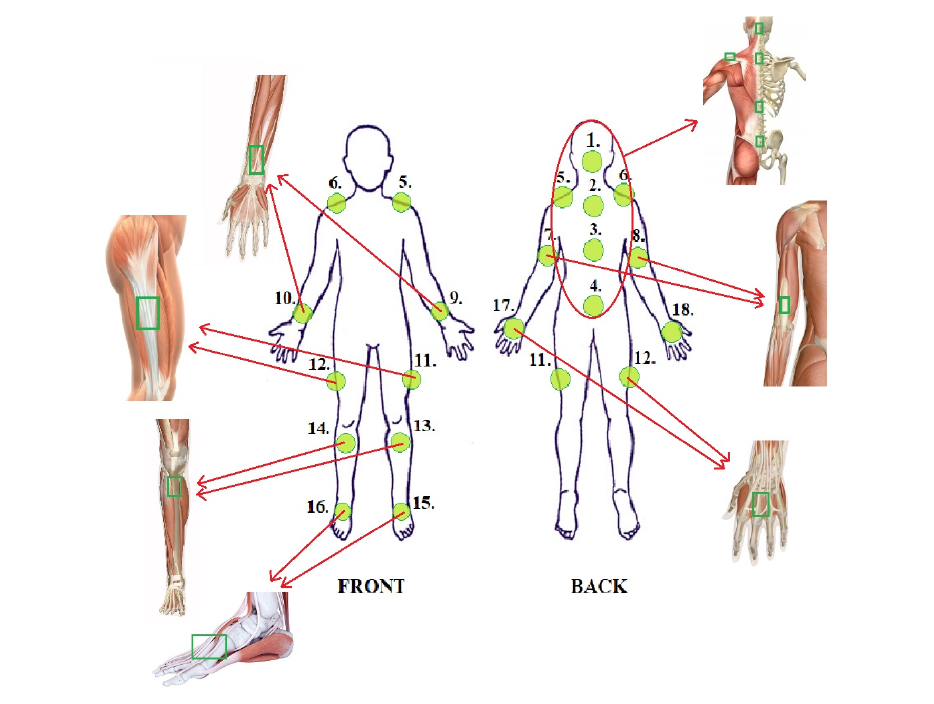
Figure 3. Sensor